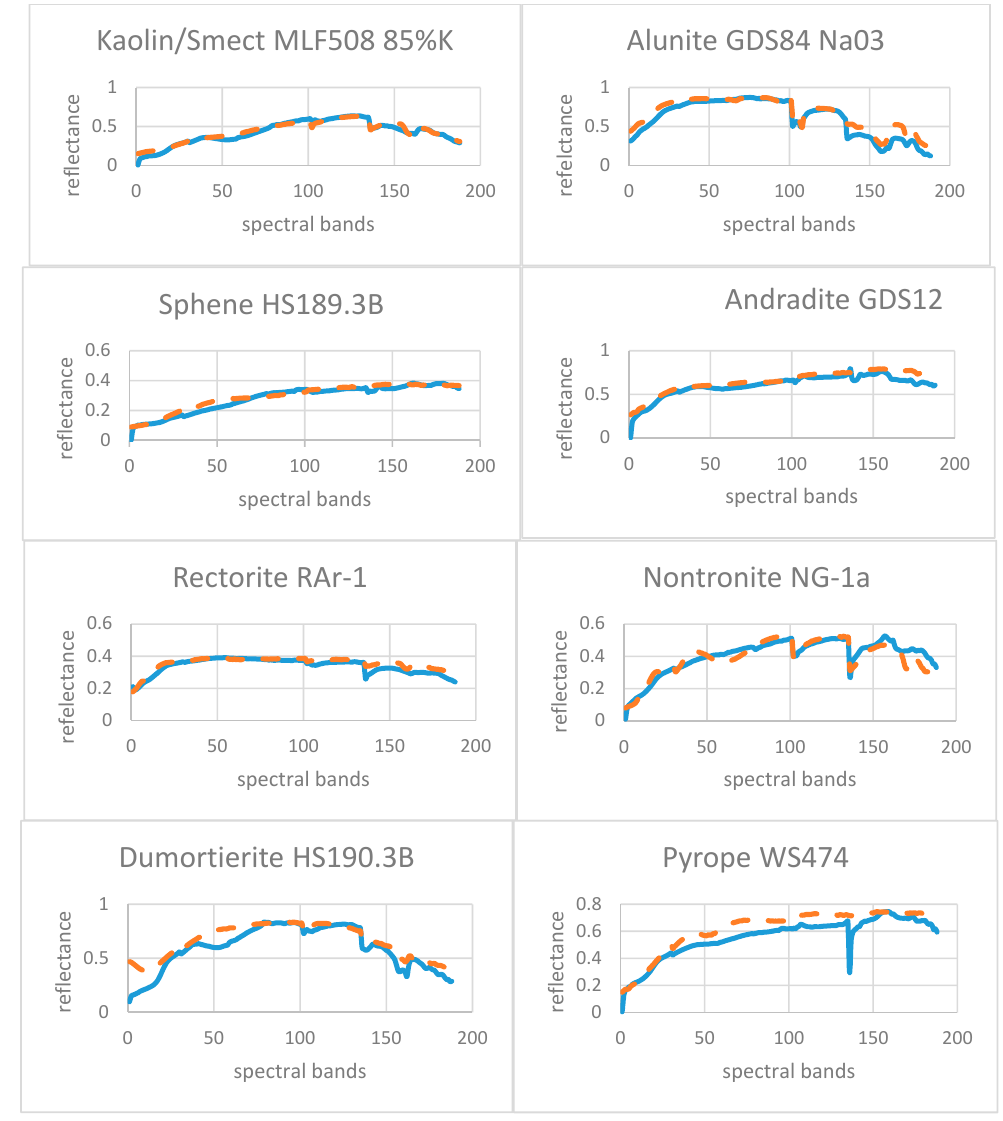
Figure 13. Original spectral signatures (blue solid lines) and estimated ones by HWSU (orange dotted lines). Table 6. Comparison of SAD on Cuprite data by HWSU, L1/2S-NMF and VCA.